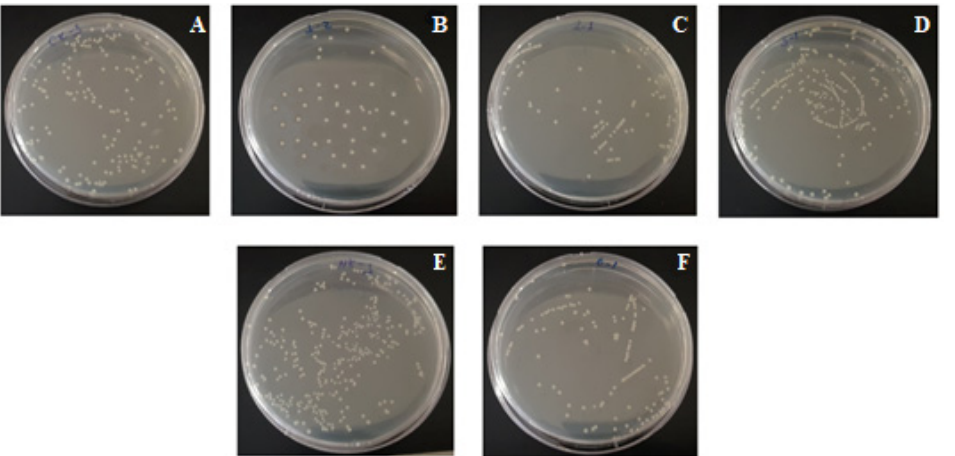
Figure 8. Cell viability (%) of Staphylococcus aureus ATCC 25923.